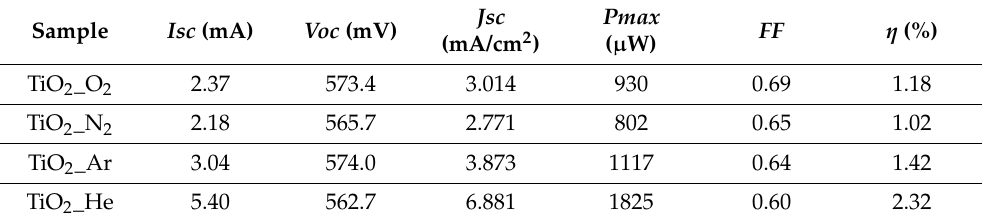
Table 3. Electro-optical parameters: short-circuit current ( I SC ); open-circuit voltage ( V OC ); short-cir- cuit current density ( J SC ); maximum power ( P max ); fill factor ( FF ); and photovoltaic conversion effi- ciency ( η ) of typical DSSCs measured under standard illumination conditions.